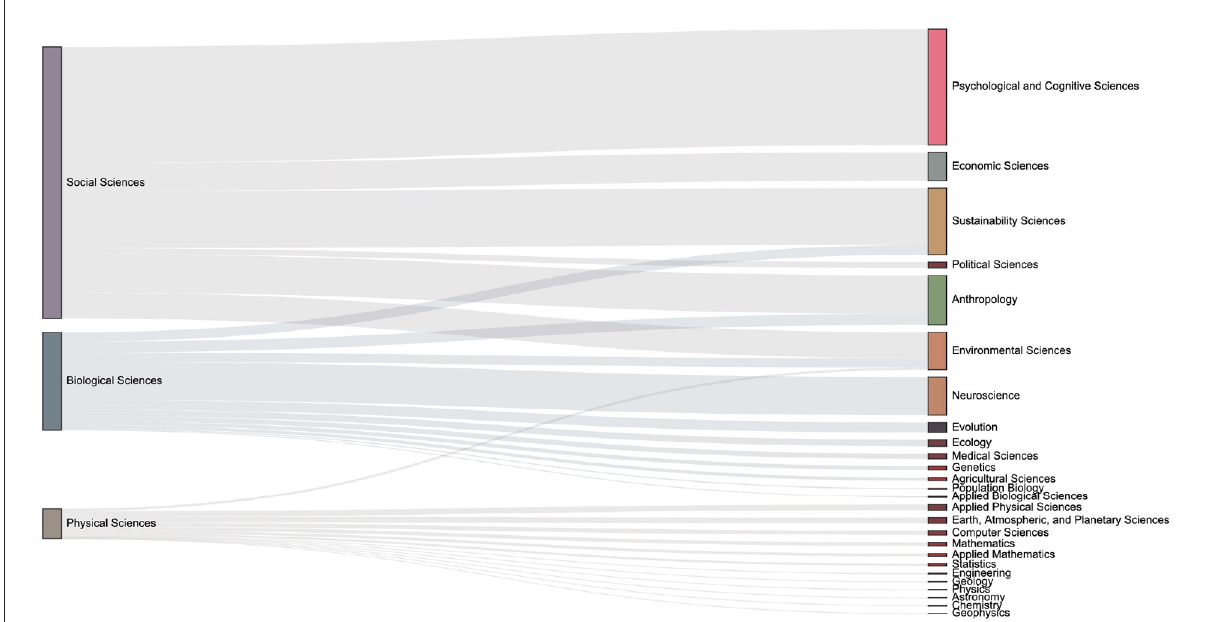
FIGURE12 The distribution of keyword mention times in various fields in the 2010s. One can observe the number of articles in each sub-category from the size of the box on the right column. Compared with the previous period, it can be seen that there are increasing discussions related to the Environmental Sciences.